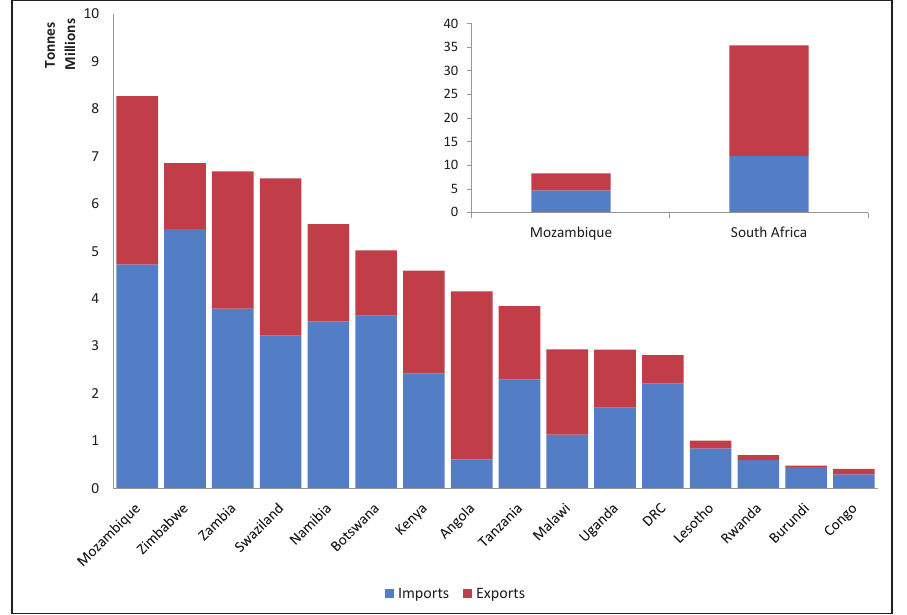
Figure 3: Comparing intra-SSA trade volumes for 2010